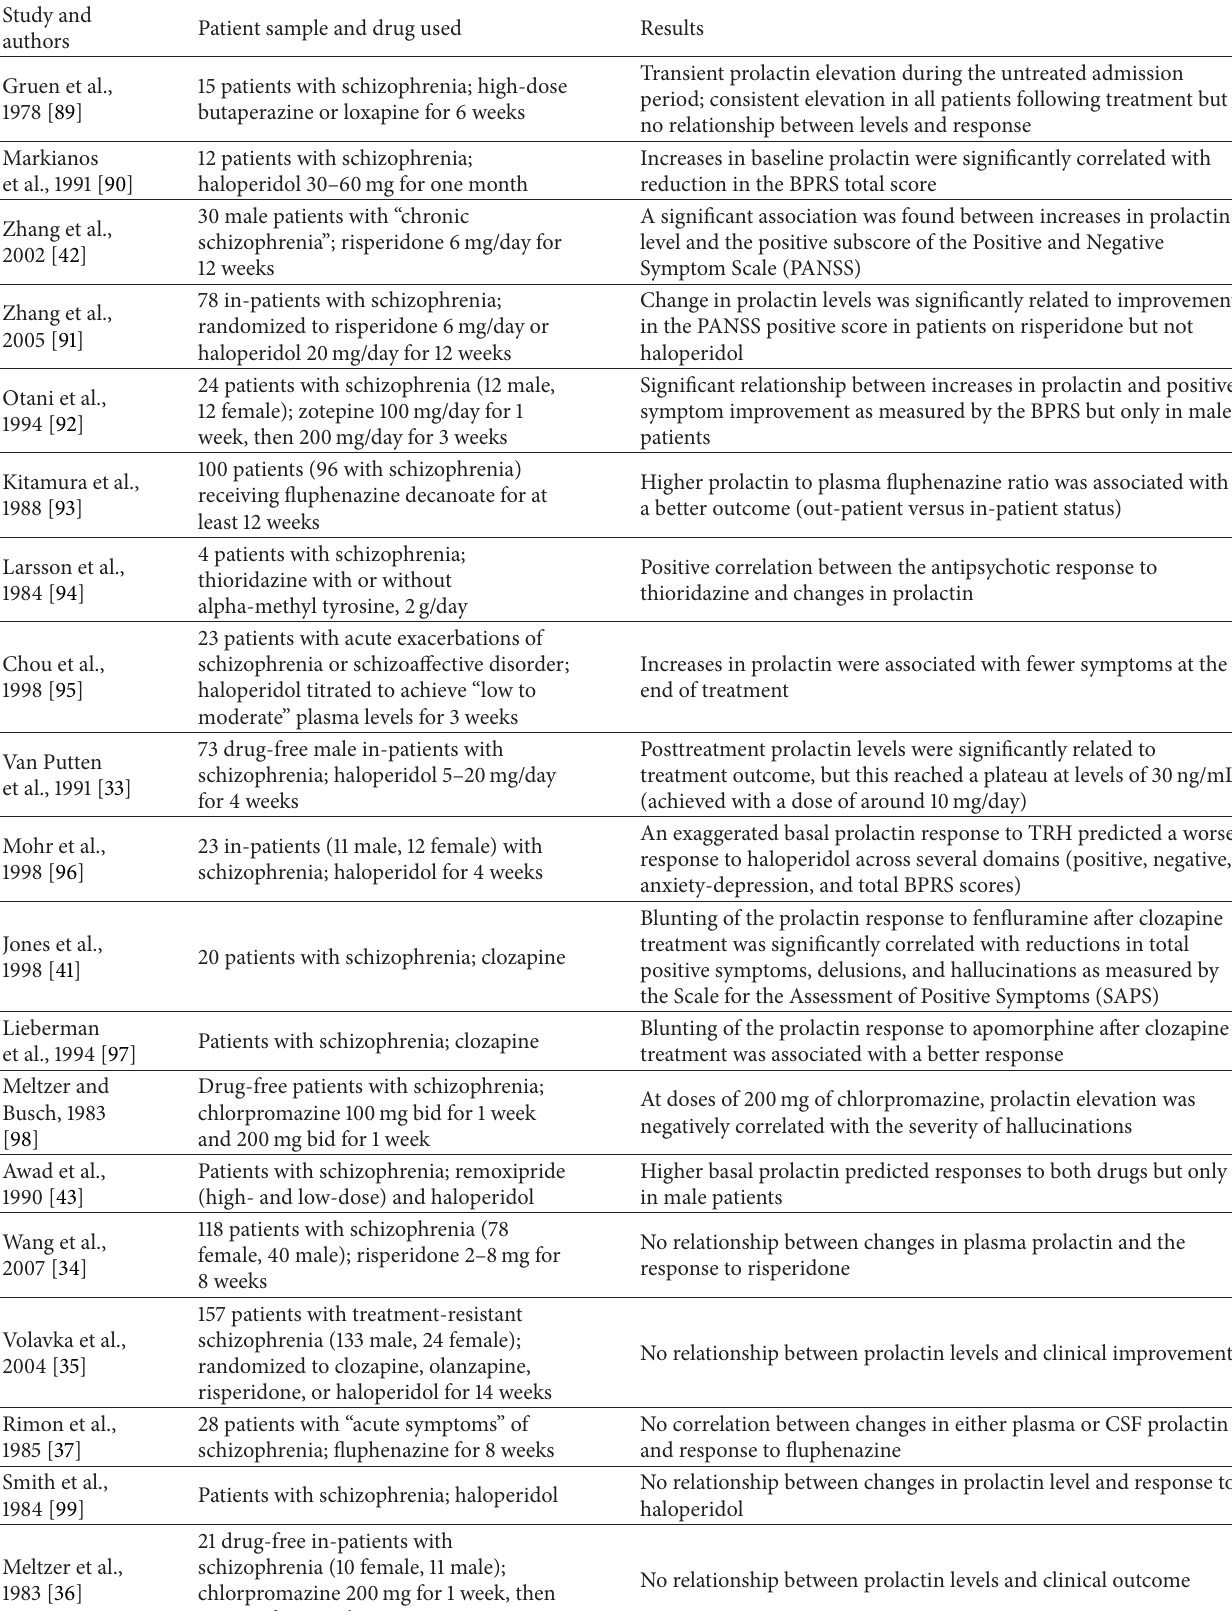
Table 4: Studies examining the relationship between measures of prolactin and antipsychotic response in